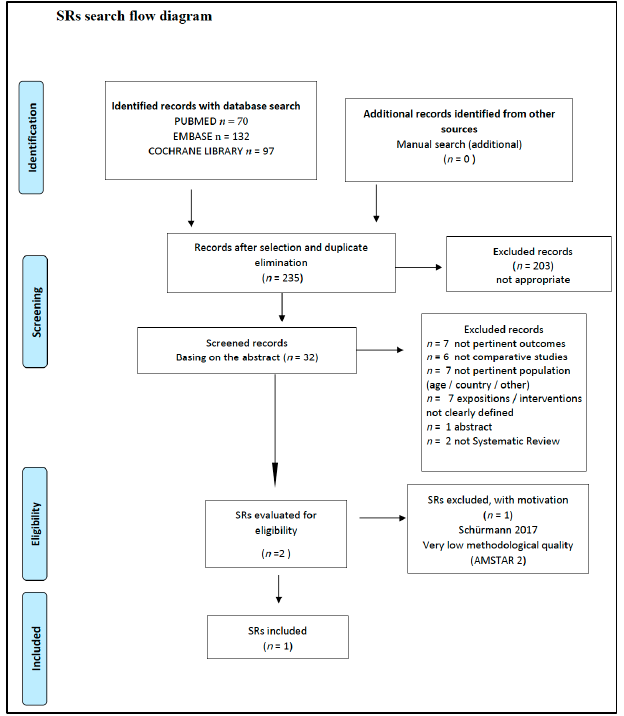
Figure 2. Vegetarian diets and different auxological development and/or growth. Flow diagram of the SRs search. SR: Systematic Review.